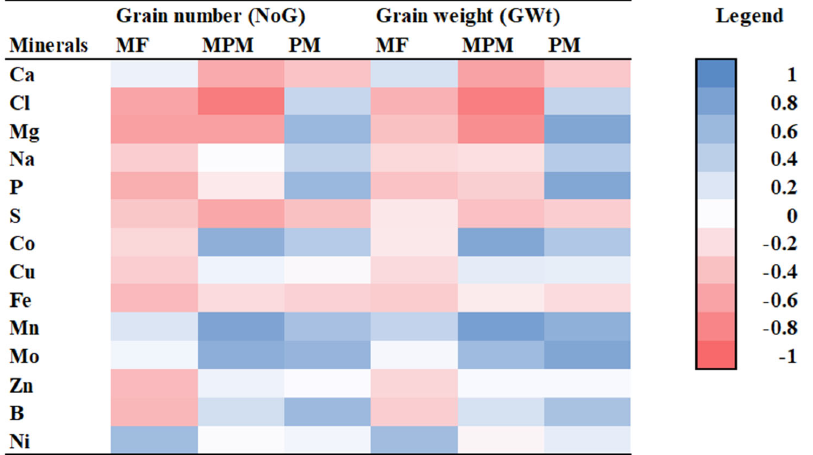
Figure 5. Correlation coefficients between grain mineral concentrations and grain yield for soil amendments. PM—poultry manure, MF—mineral fertilizers, and MPM—complementary (50:50) application of poultry manure and mineral fertilizer.